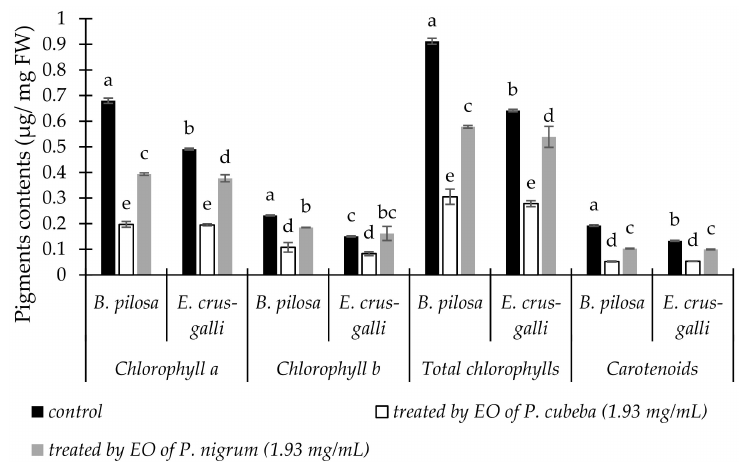
Figure 1. The changes of pigment contents of B. pilosa and E. crus-galli between control and treatments. Data were presented in means ± standard deviations (SD). Means with di ff erent small letter in the same pigment indicted significantly di ff erent by Fisher’s test ( p < 0.05).